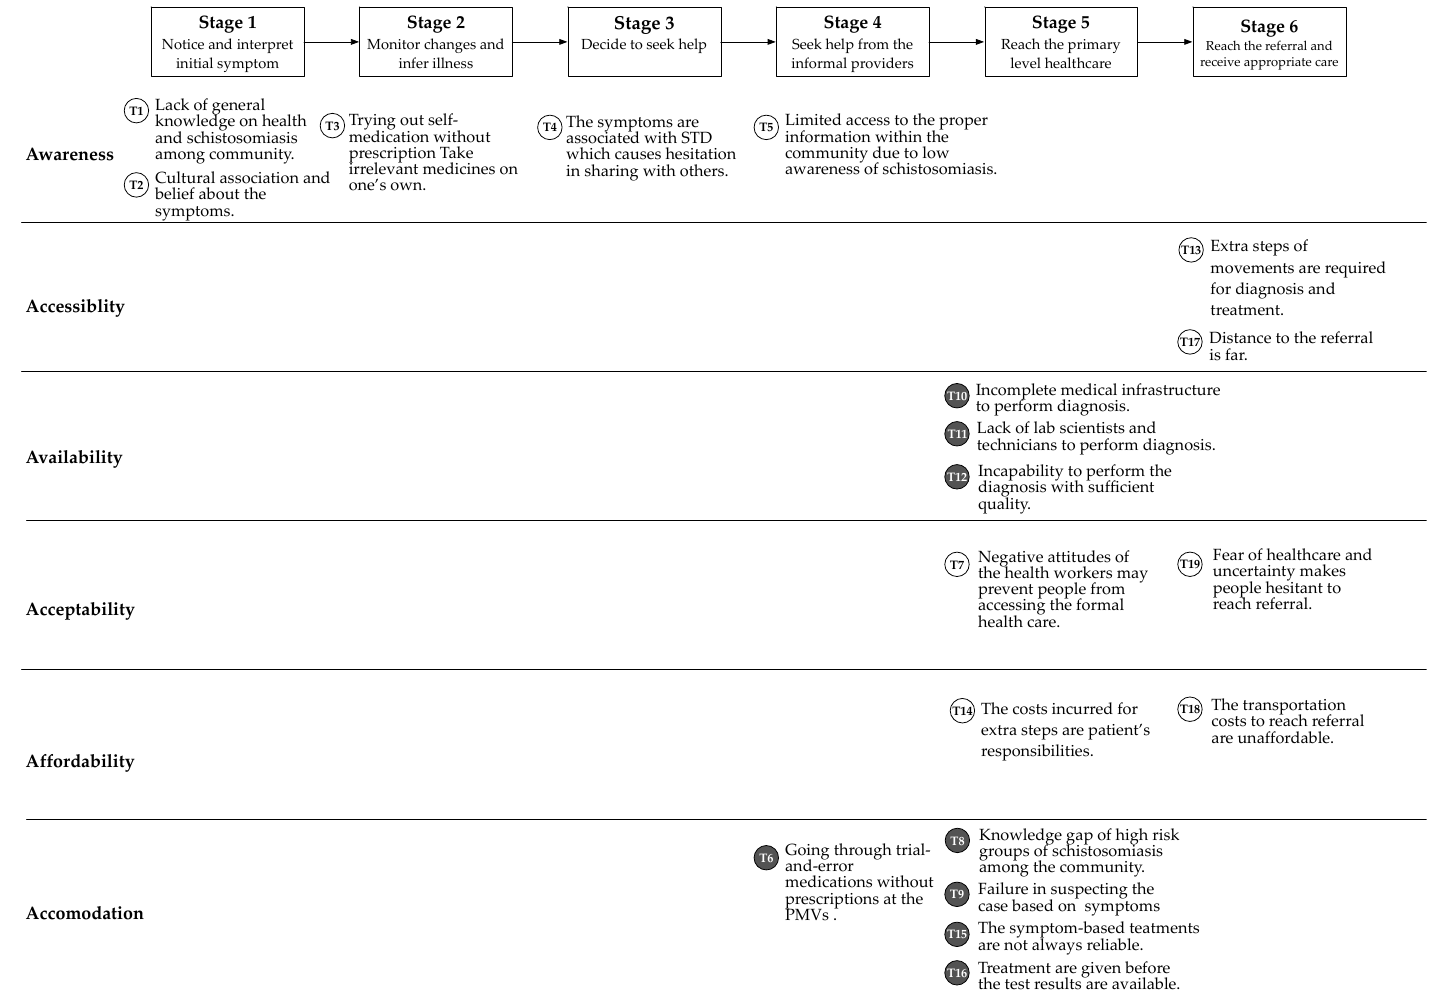
Figure 2. Identified barriers in the case management and diagnosis in 6A Framework. ○ = Barriers from the healthcare seeker perspectives, ● = Barriers from the healthcare provider perspectives.